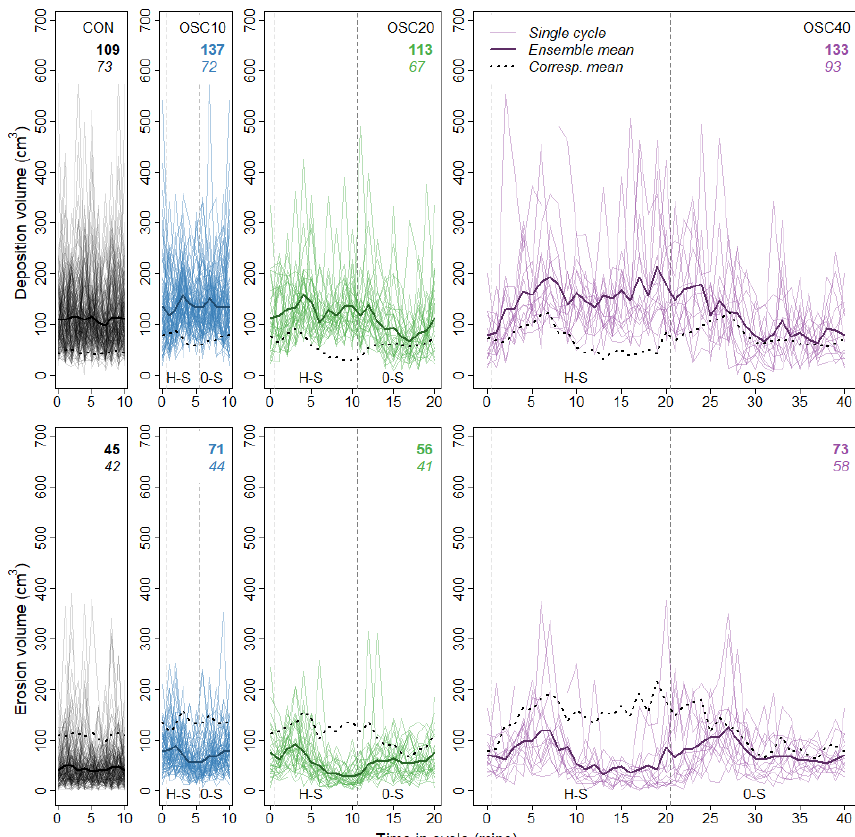
Figure 9. Deposition and erosion volumes (across the whole fan) versus time in the sediment supply oscillation cycle. The thin lines represent each individual supply oscillation cycle; the thick lines are the ensemble means. The dashed black lines (“Corresp. mean”) show the mean from the corresponding upper or lower plot; for instance, the dashed black line in the top-right deposition plot shows the mean erosion volume from the plot below, allowing direct comparison of erosion and deposition. H-S denotes the high-supply period; 0-S denotes zero sediment supply. Coloured text indicates each experiment’s time-averaged mean (in bold) and standard deviation (in italics). Figure S9 also overlays these data for